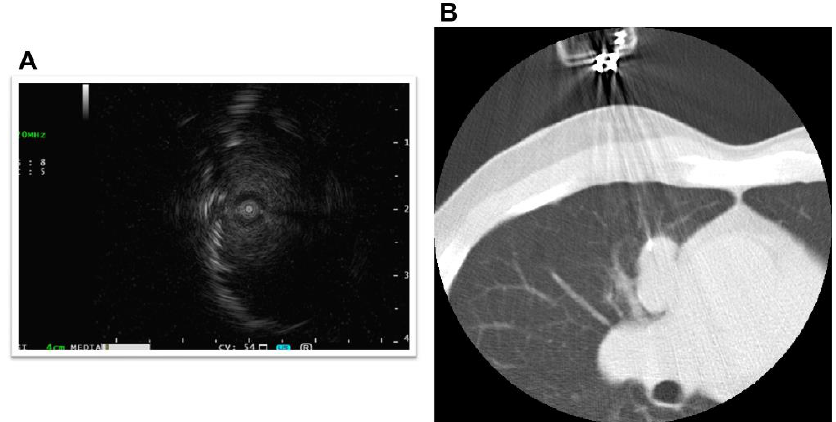
Figure 2. Bronchoscopy and computed tomography-guided biopsy. A thin bronchoscope, endo- bronchial ultrasonography, and a guide sheath were used during the bronchoscopy ( A ). Biopsy was performed under computed tomography guidance ( B ).